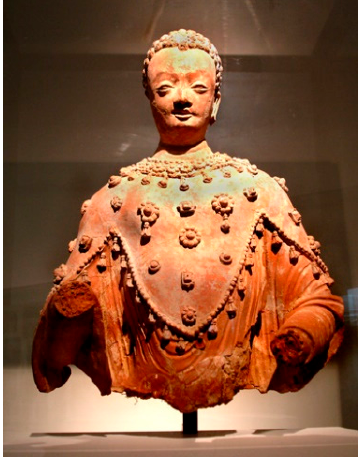
Figure 4. Buddha wearing a jeweled cape. Clay fragment from niche D, seventh c. Fondukistan. Musée Guimet, Paris. Photograph from Twist, courtesy of the Musée Guimet.